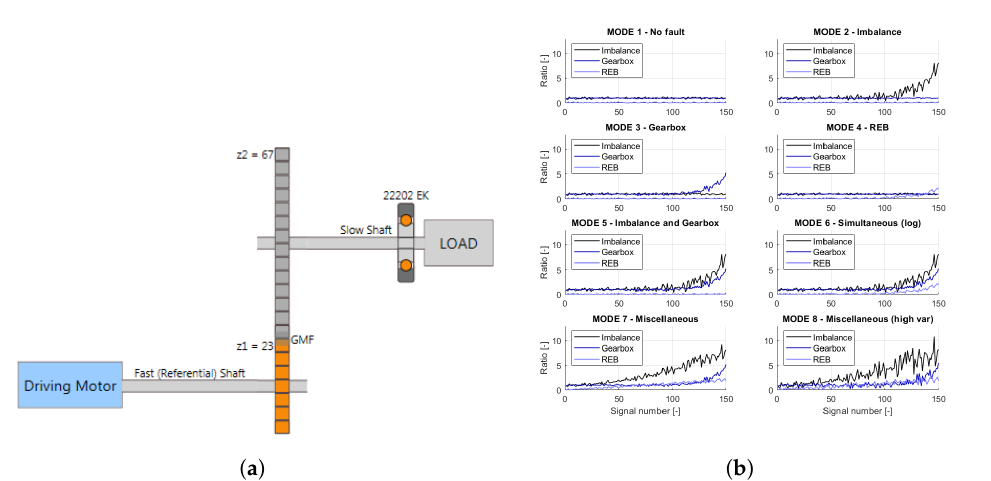
Figure 10. ( a ) Simulated object kinetostatic scheme [34]; ( b ) failure development functions for a nominal velocity of 3000 rpm [34].